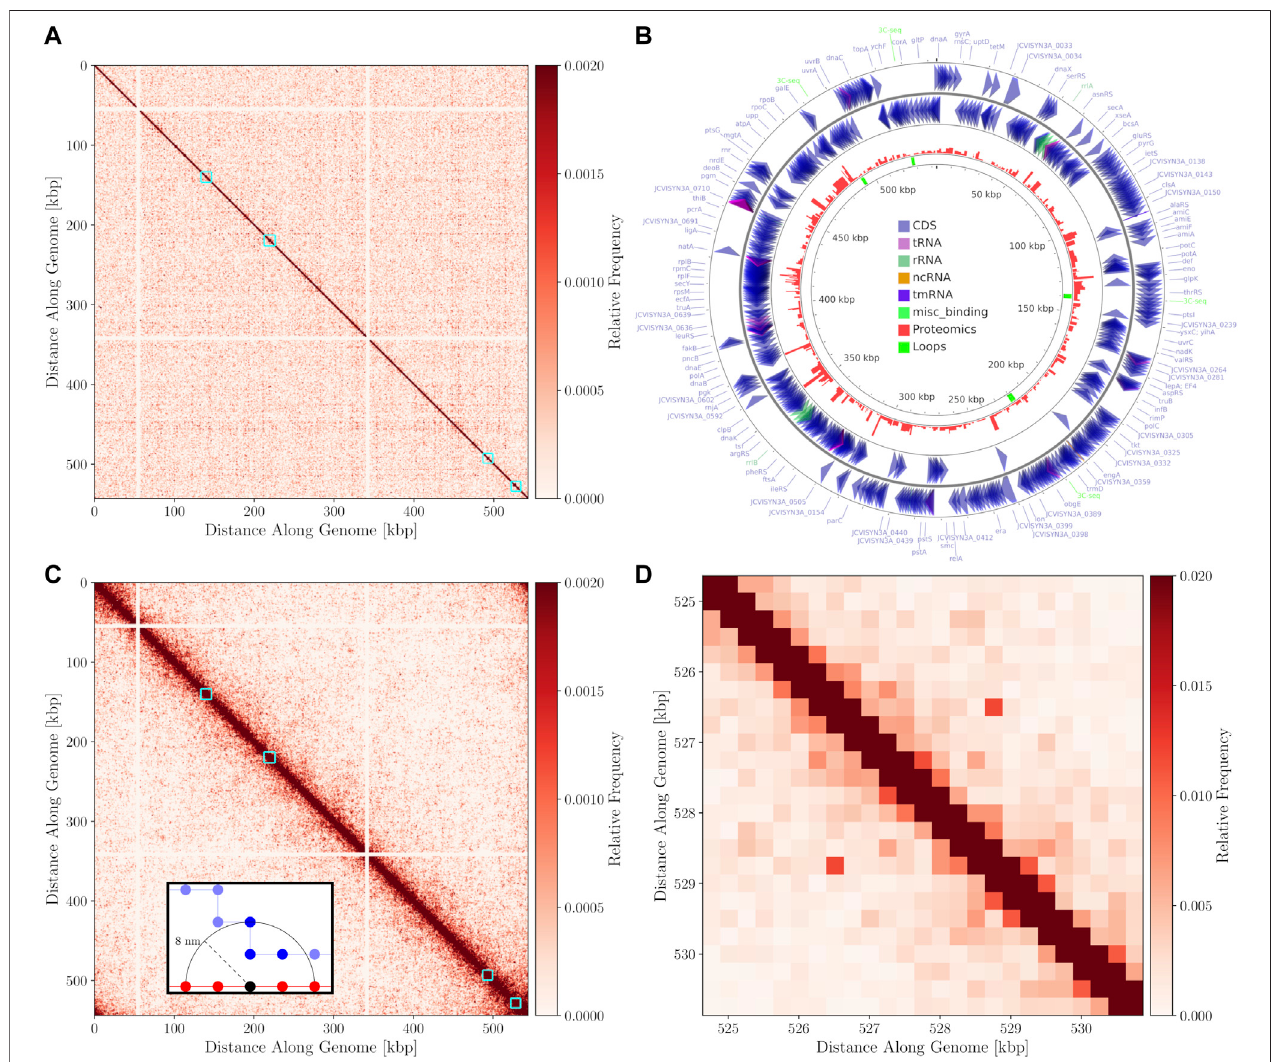
FIGURE 7 | (A) — 3C-Seq contact map at 1,000 bp resolution with the color-scale adjusted to make weak secondary features along the diagonal more apparent. Thefourmanuallyannotatedloopslisted in Table2 areindicatedwithcyanboxes. (B) — CircularchromosomeofSyn3A withfeaturesshown asarrowsand arcsaround theperimeter-constructedusingCGview(Petkauetal.,2010).Theproteomicsofa400 nmSyn3A cell(Breueretal.,2019)areplottedinredaroundthemiddleringand the innermost ring contains the annotated loops in green. (C) — In silico contact map resulting from 150 con fi gurations with looping interactions added at the positionsofthemanuallyannotatedloopsin Table2 .Alocussizeof1,000 bpwasusedtomatchthe3C-Seqmap.TheinteractionsattheribosomalRNAoperonshave been removedfromthemap toenhancevisualclarity.Cyansquaresareagainused toindicateregionscontainingtheloops. (D) — Magni fi edviewoftheregionwithinthe cyan square containing the fourth loop in the in silico contact map. The map was recalculated at a resolution of 250 bp and the maximum of the color-scale was increased to better resolve the characteristic signature of a loop.